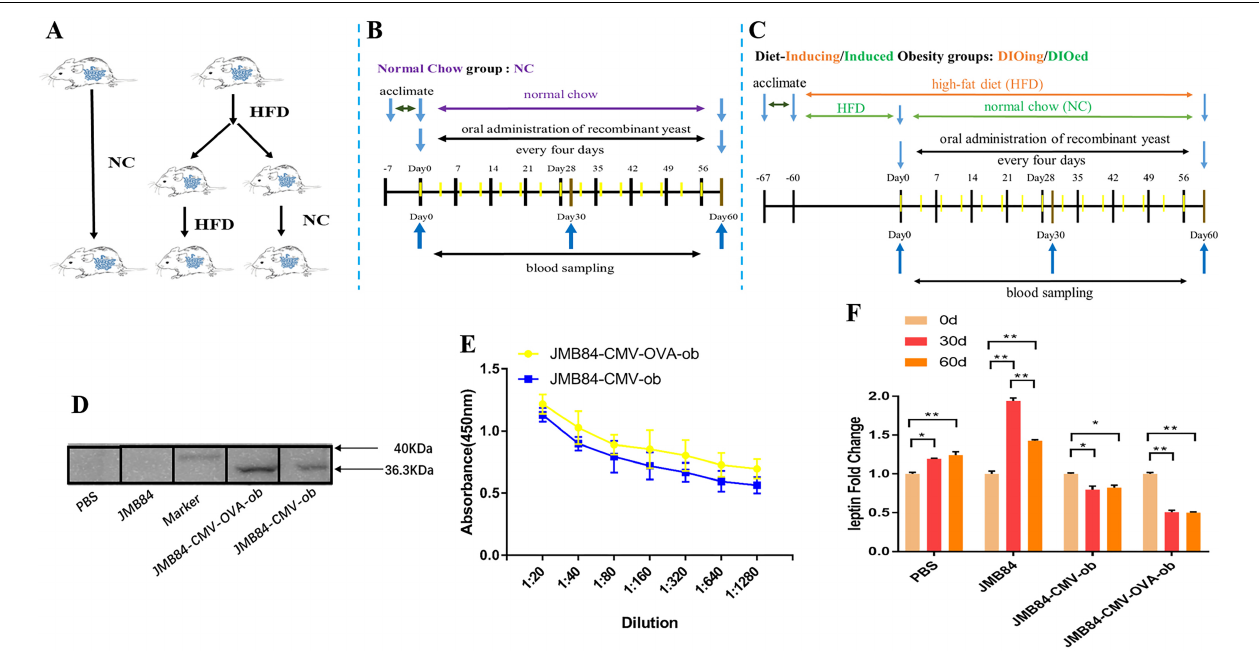
FIGURE 2 | Oral immunization groups and timelines, preliminary immune response induced by oral administration of ob recombinant yeast in NC mice. (A) Oral immunization groups. (B) The feeding, oral immunization, and blood sampling timeline for the NC group. (C) The feeding, immunization, and sampling timeline for the DIOing and DIOed groups. (D) WB assay result with purified leptin recombinant protein as the antigen and different antiserums (Day60) from different treatments as the primary antibodies. (E) ELISA result for anti-leptin antibody titering in the antiserums (Day60) from the oral immunized mice by ob recombinant yeast. (F) The changes in circulating leptin were detected by ELISA in the antiserums (Day0, Day30, and Day60) from different treatments. The * sign indicates statistical significance at a P value of < 0.05; ** represents P < 0.01.